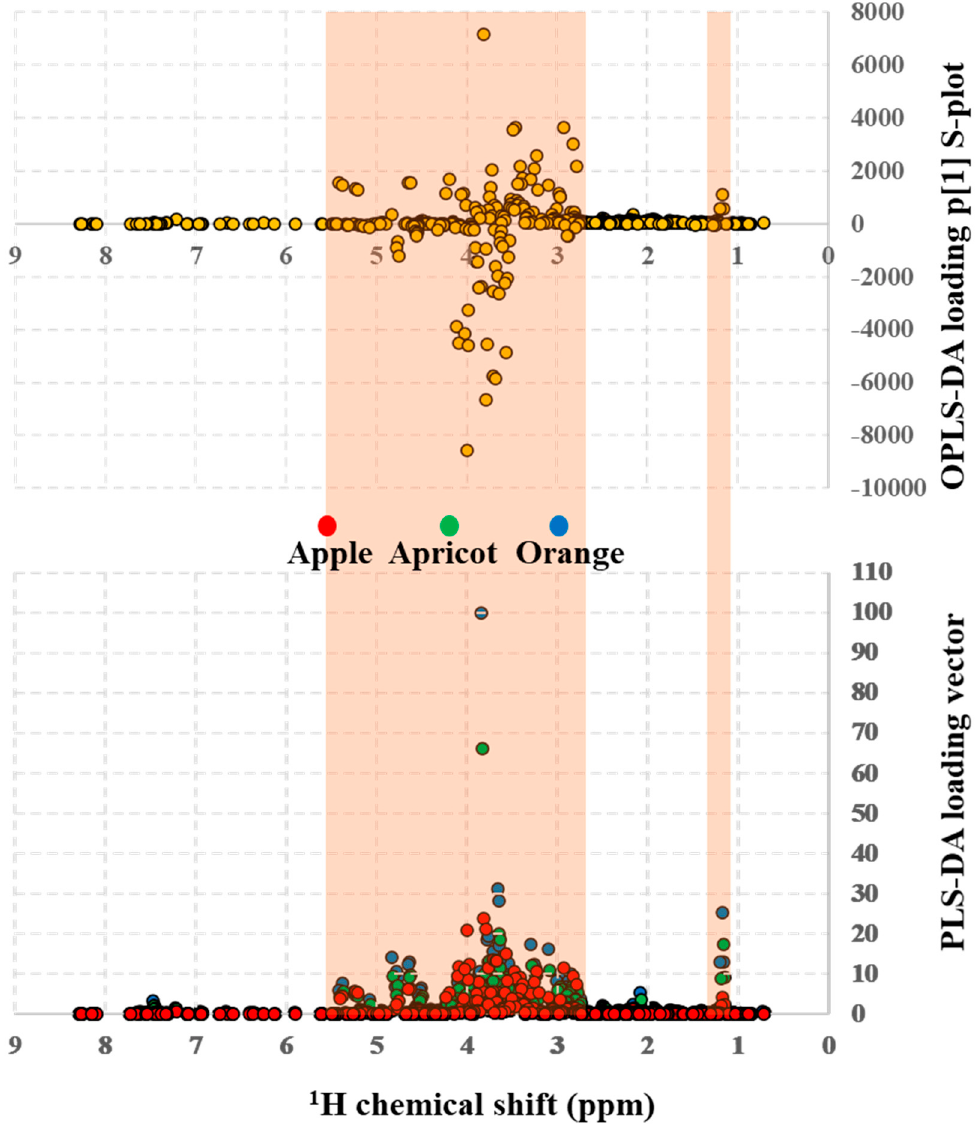
Figure 6. OPLS-DA loading p [1] S-plot ( top ) and PLS-DA loading vectors ( bottom ) as a function of { 1 H water_presat NMR} chemical shifts from 100% apple (red), orange (blue), and apricot (green) the fruit beverage supervised discriminant analysis (Figure 4B,D) that indicates the importance of relevant metabolites used for “types of fruit” in juice discriminations.